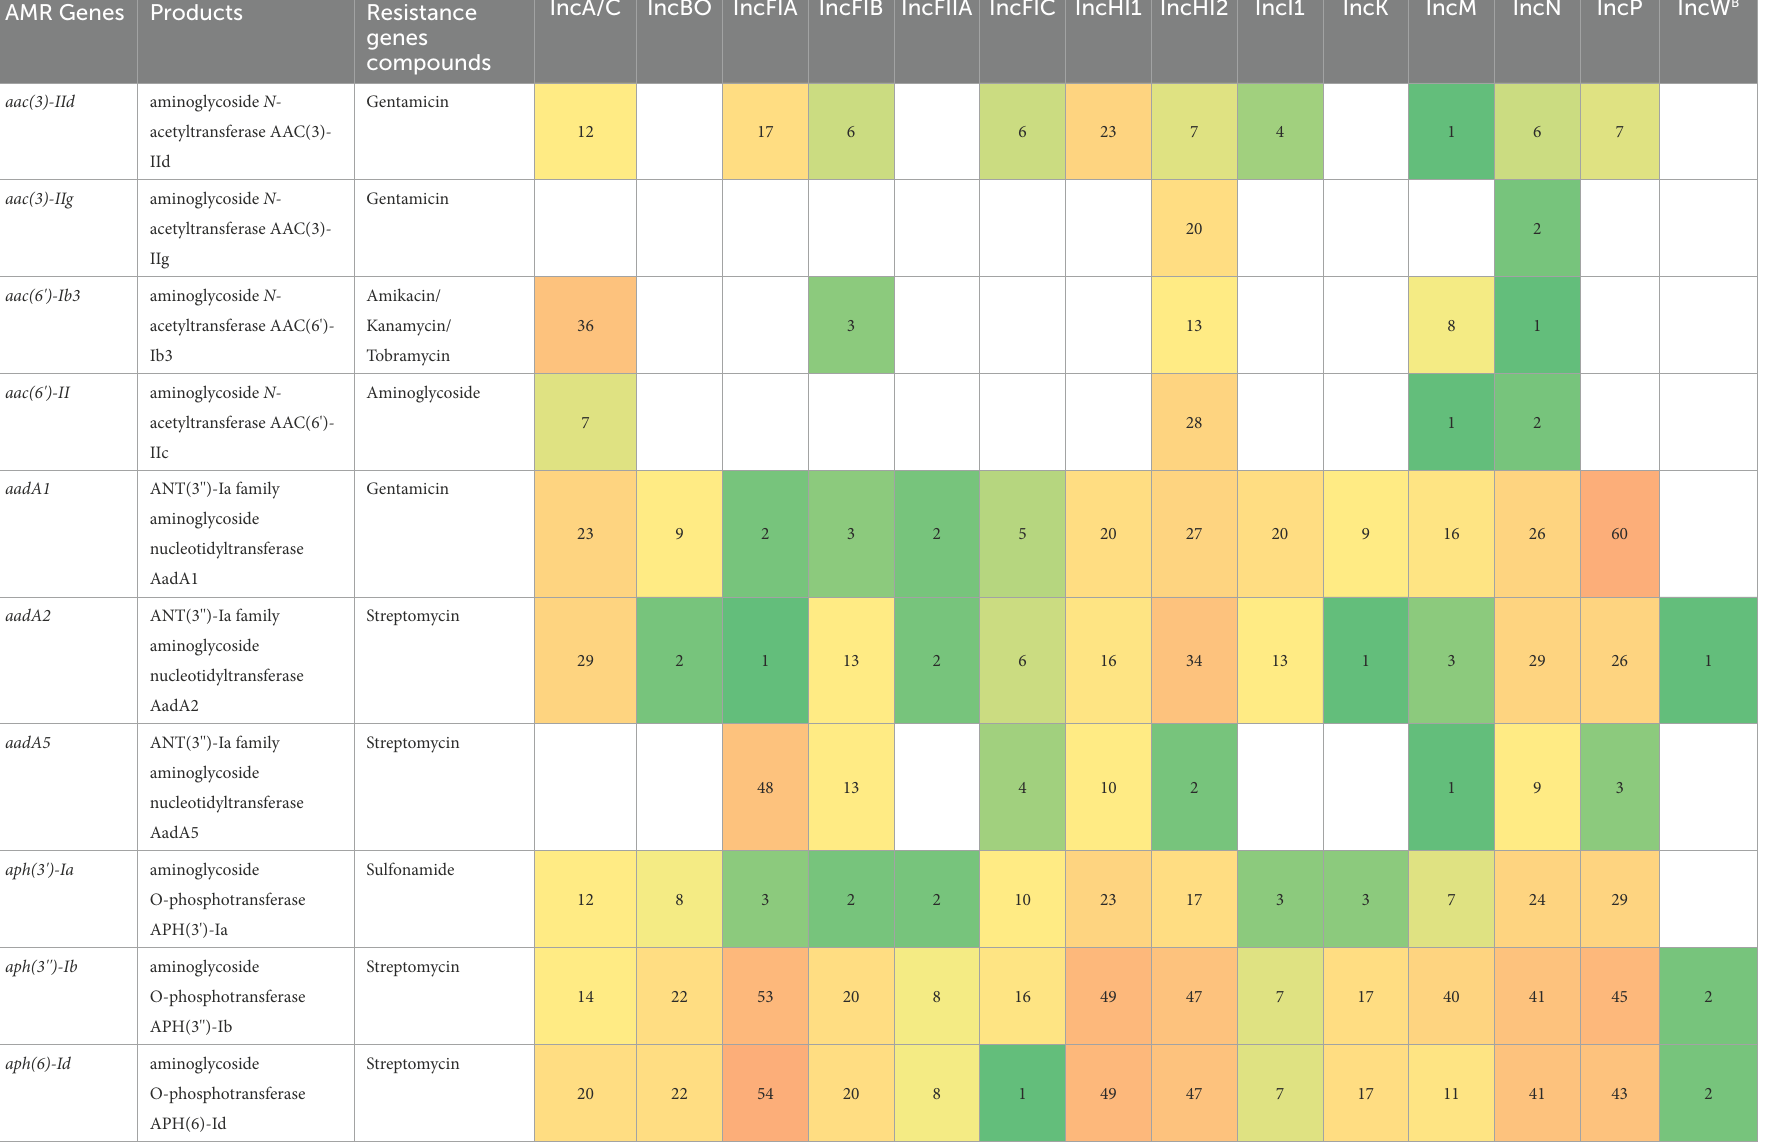
TABLE 1 Numbers of representative A antimicrobial resistance genes detected in 100 B sequences for each plasmid replicon type identified using